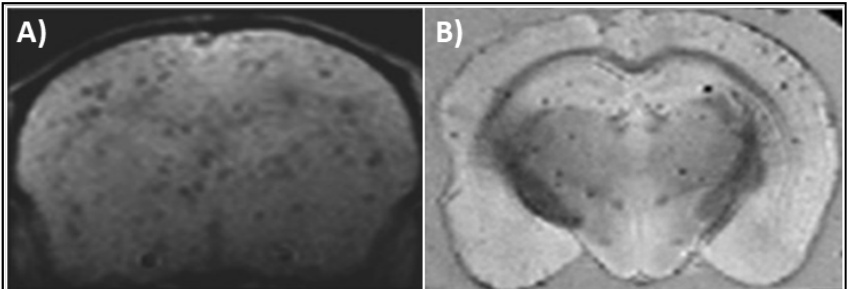
Figure 2. Coronal MRI images showing detection of functionalized iron oxide nanoparticles (IONPs) in Alzheimer’s disease (AD) mouse brain regions. ( A ) In vivo T2* weighted image in APPswe/PS1dE9 transgenic AD mouse brain 12 h after intravenous injection of Congo red/Rutin conjugated IONPs at 7T MRI. Study by Hu et al. [32] . ( B ) Ex vivo T2* image of 18-month old Tg2576 transgenic AD mouse brain 4 h after intravenous injection of curcumin conjugates polyethylene glycol (PEG)-supported IONPs at 7T MRI. Study by Cheng et al. [25] . Images adapted with permission.